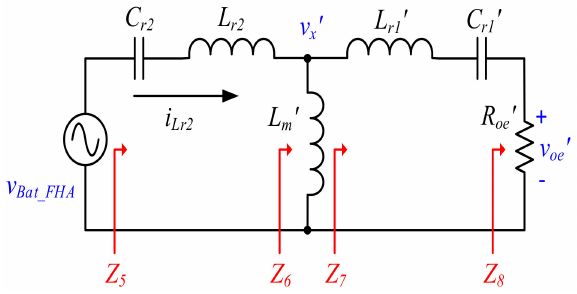
Figure 8. AC equivalent circuit of converter in the reverse